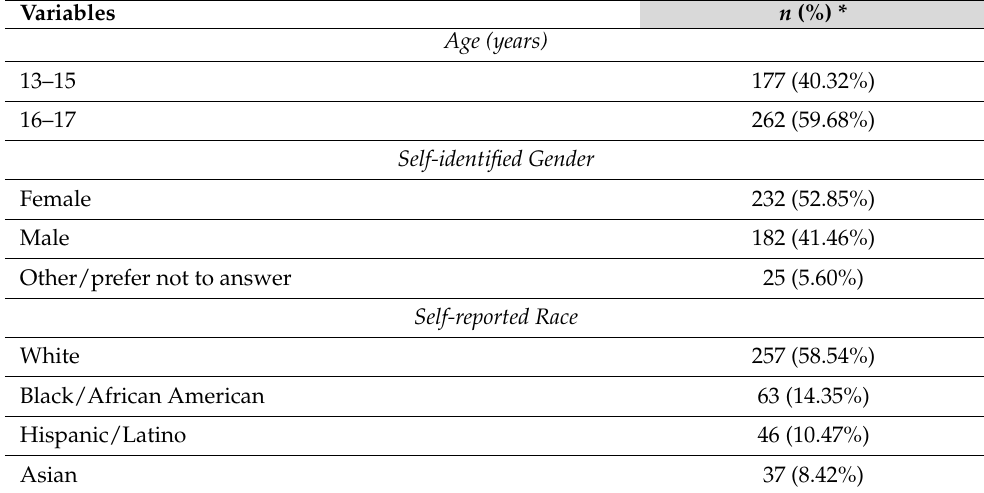
Table 1. Participant characteristics (total n =